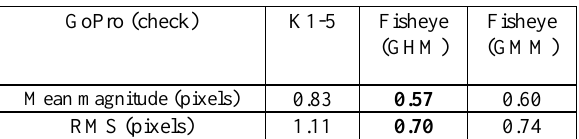
Table 5. Precision on check images of GoPro camera in check adjustment using the calibration parameters estimated via various calibration models, based on 3D target-field observations.